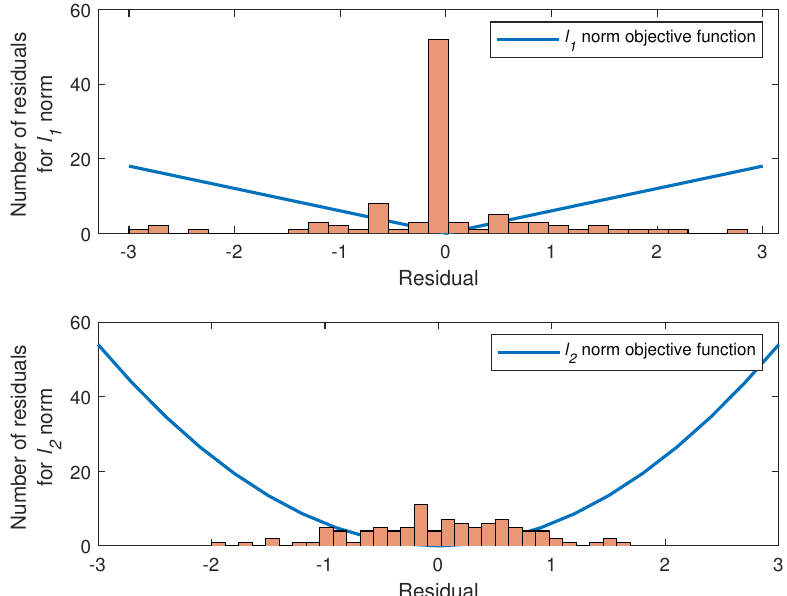
Figure 5. Histogram of residual amplitudes for l 1 and l 2 norm solutions